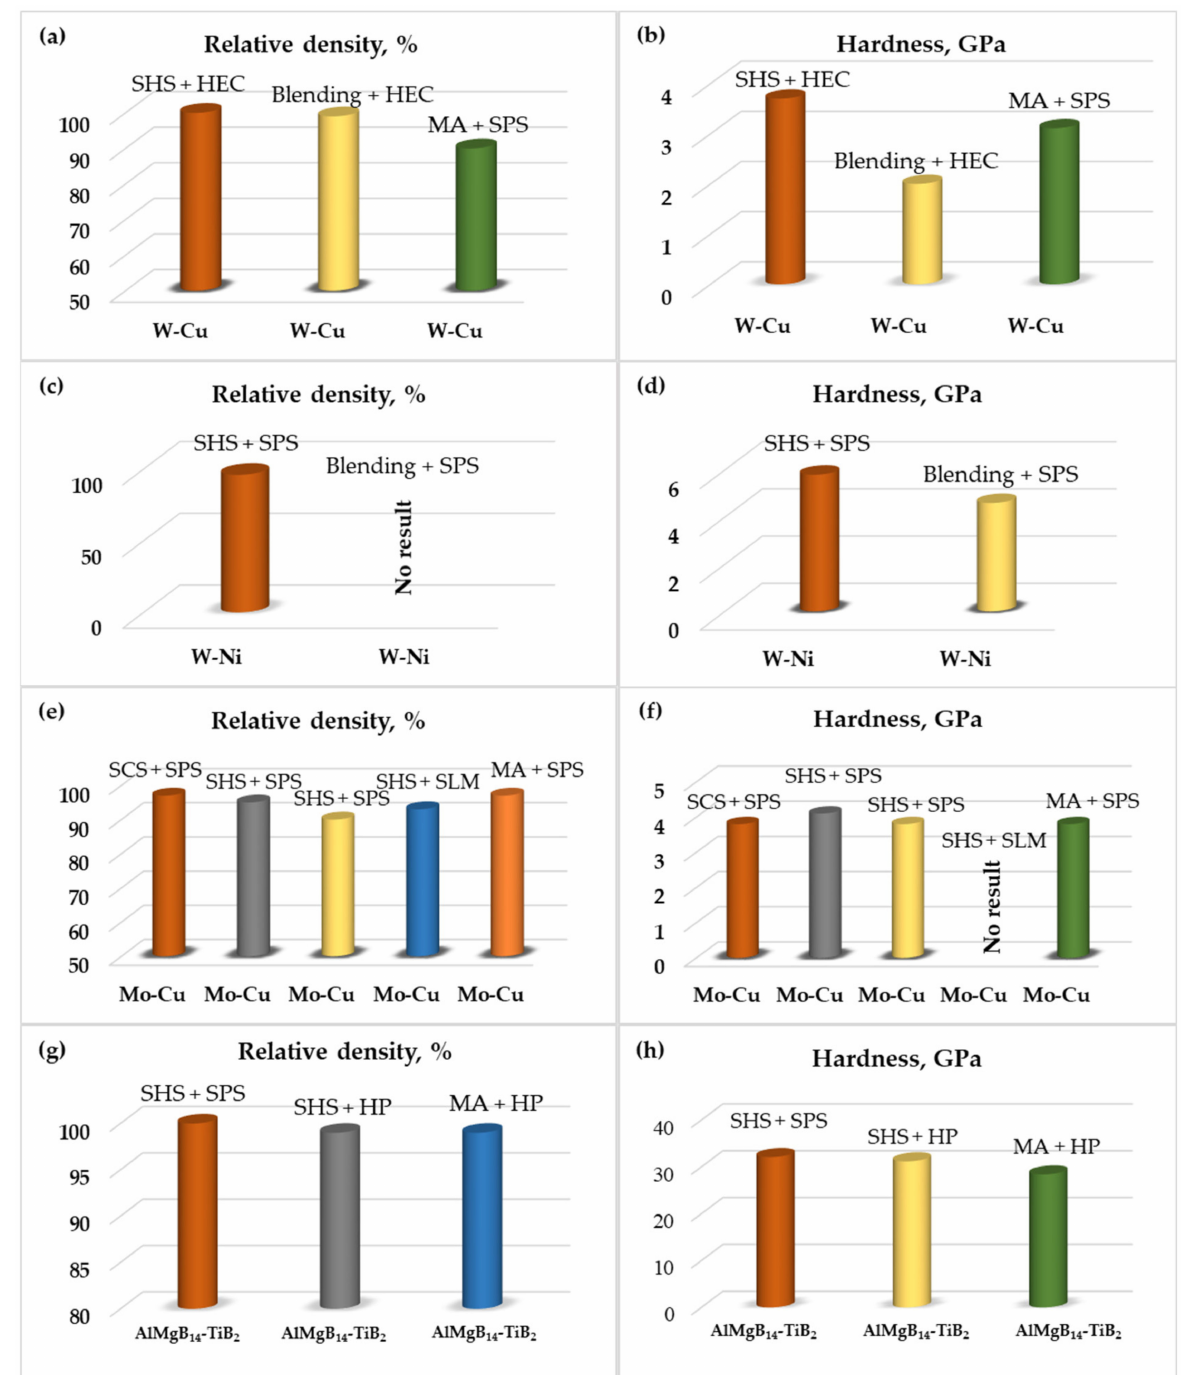
Figure 10. Plots of hardness and relative density values for the systems under consideration; W-Cu ( a , b ), W-Ni ( c , d ), Mo-Cu ( e , f ), AlMgB 14 -TiB 2 ( g , h